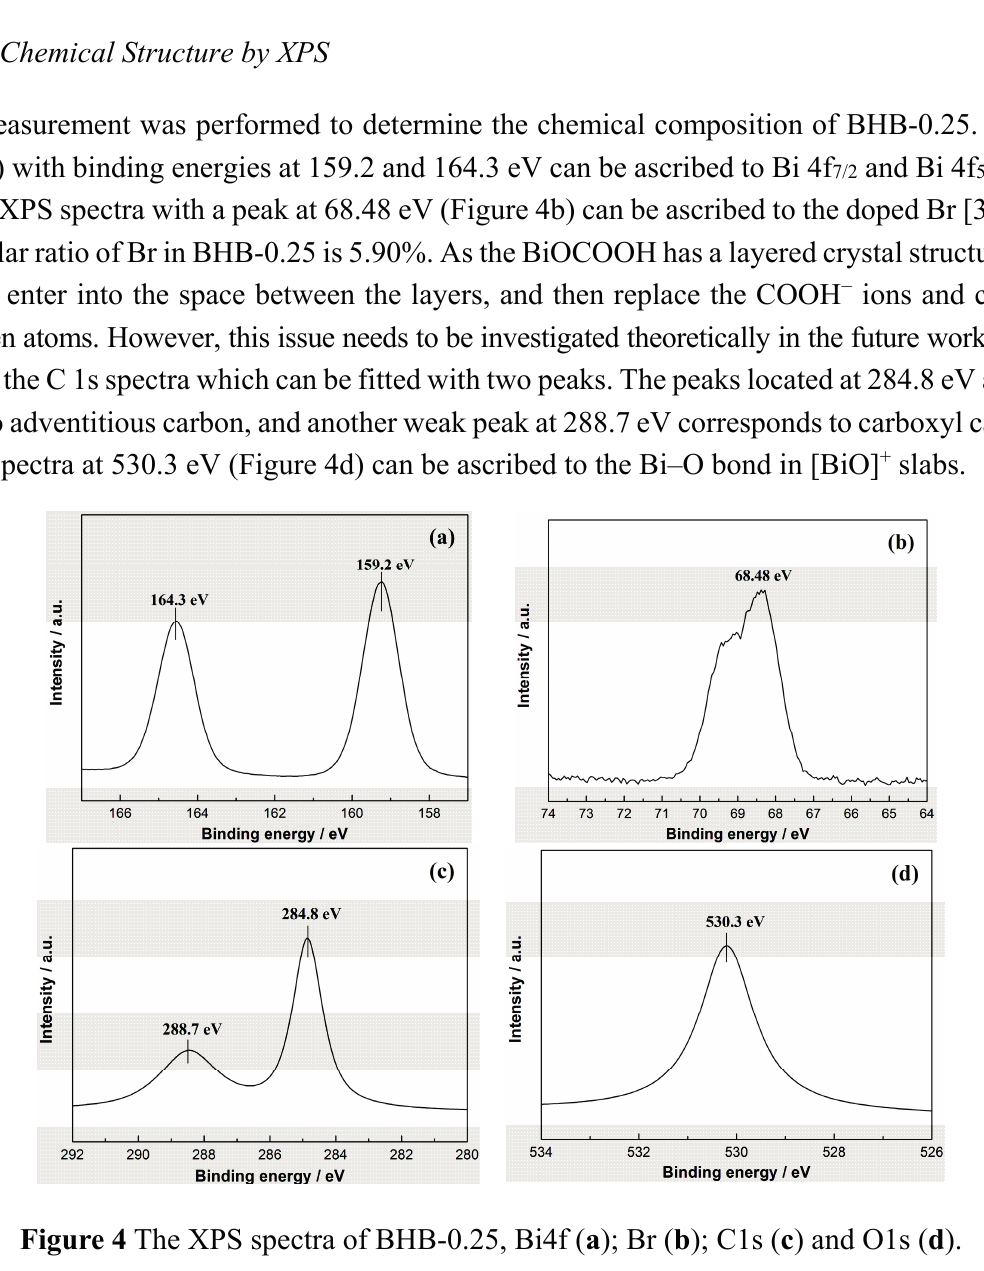
Figure 3. The SEM ( a , b ); TEM ( c ) and HRTEM ( d ) images and EDS mapping ( e – h ) of BHB-0.25.